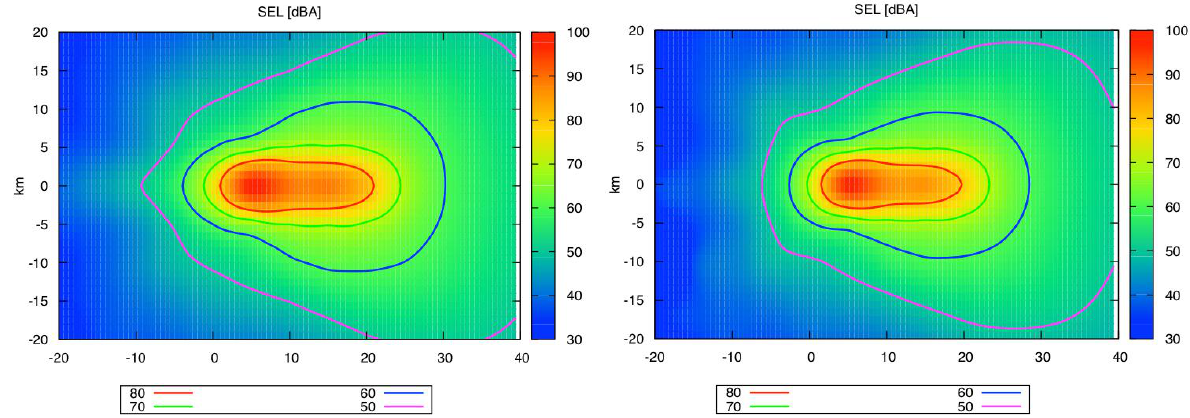
Figure 10: Contraction of the SEL contours produced at takeoff by LNT for the twin-engines, mid-range aircraft. The overall reduction of the area bounded by the 60 db(A) contour for the two compared solutions is about 15%.